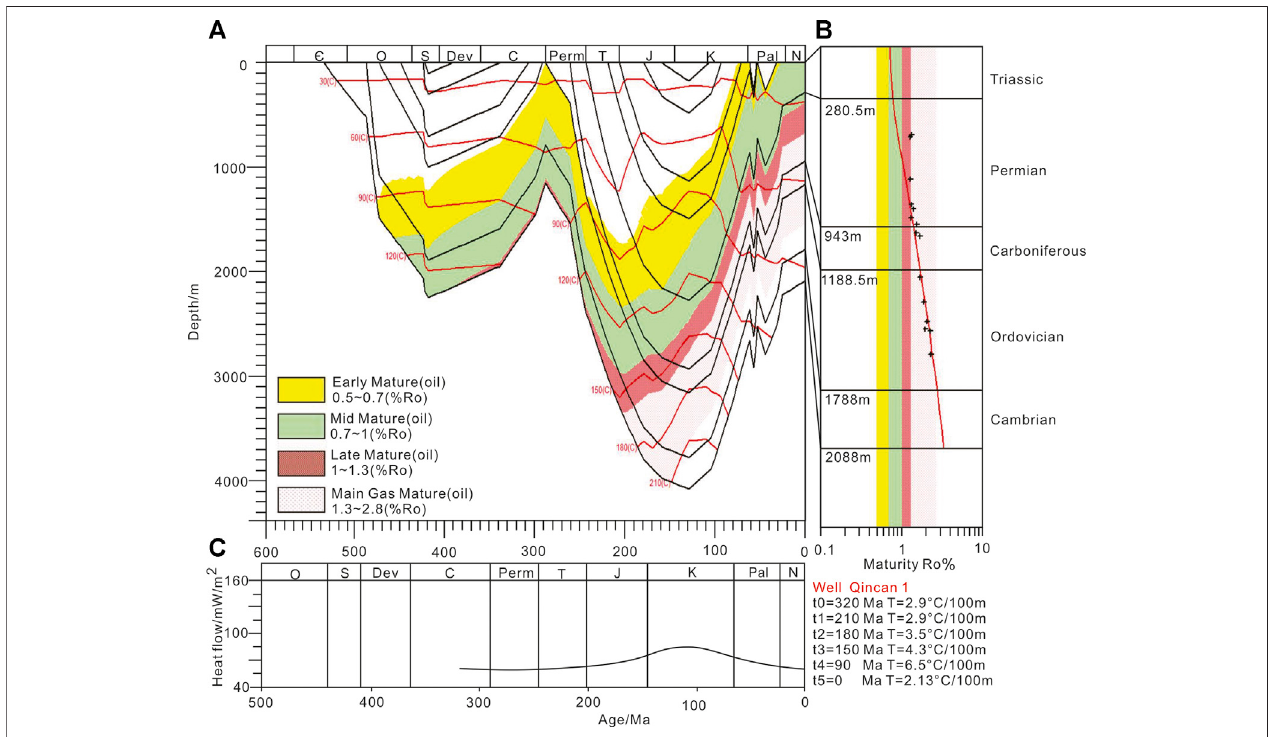
FIGURE 10 | Recovery of burial history and tectono-thermal history of Qincan 1 well in central Qinshui Basin. (A) Burial history and tectono-thermal history of Qincan 1 well. (B) Fitting relationship between measured Ro and simulated Ro. (C) Geothermal fl ow evolution in different periods of Qincan 1 well.